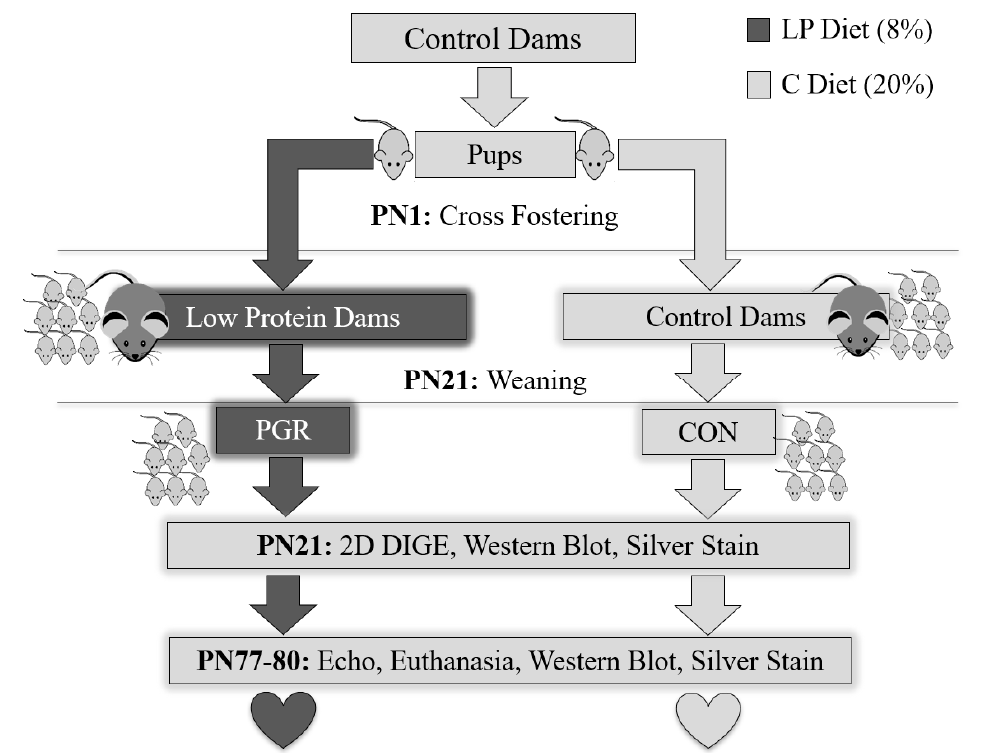
Figure 8. Experimental design. Two weeks prior to mating, dams were fed either a control diet (C: 20% protein) or isocaloric low-protein diet (LP: 8% protein). At birth, pups born to LP dams were sacrificed, while CON pups were cross-fostered to either a different control-fed dam (CON group) or a low-protein-fed dam (PGR group). At PN21, mice were weaned, a sub-cohort was euthanized, and hearts collected for 2D DIGE, western blotting, and silver nitrate staining (CON; n = 3 males; n = 3 females and PGR; n = 3 males; n = 3 females). PGR was restricted to the developmental window of PN1–21 as the remaining mice were fed the C diet from PN21–PN80. At PN77, cardiac function was evaluated by echocardiography (CON; n = 4 males; n = 3 females and PGR; n = 4 males, n = 5 females). Mice were given 2 days of recovery, then at PN80 were euthanized and hearts extracted for western blotting and silver nitrate